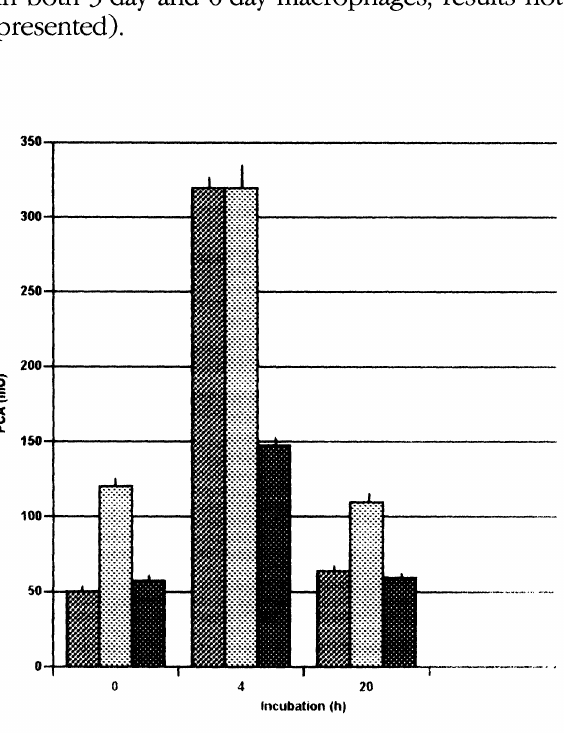
FIG. 3. The development of PCA (mU/lO 6 cells)in resident (), 3-day (iiiiiii), and 6-day macrophages (I), cultivated in M 199. Data represent the means -t- SD of the representative experi- ment (n 5-7 per group). Two to three separate experiments were done. Significant stimulation (p < 0.001): at 0 h, 3-day versus resident and 6-day macrophages; at 4 h, resident and 3- day versus 6-day macrophages; at 20 h, 3-day versus resident and 6-day